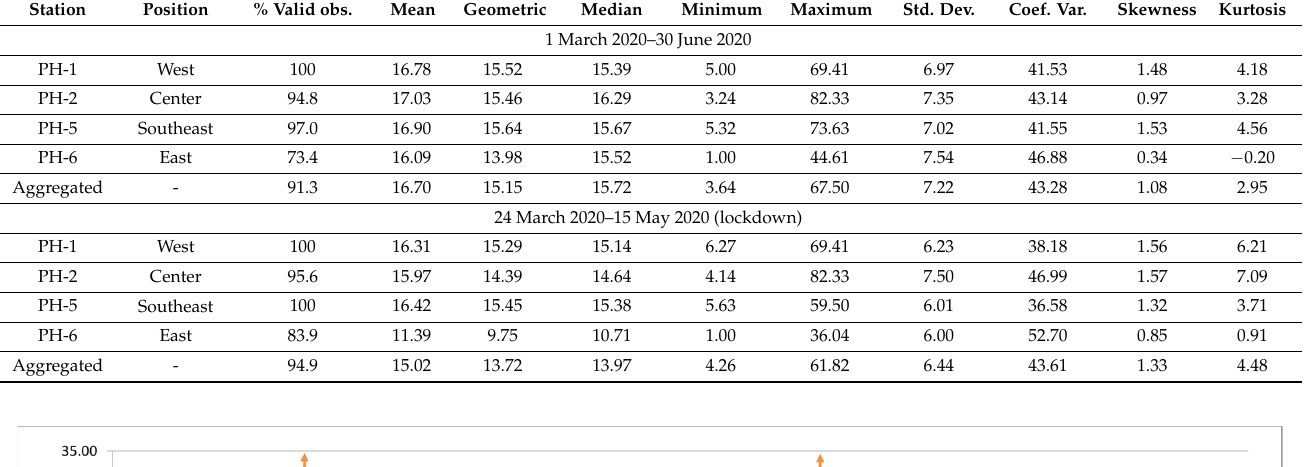
Table 2. Descriptive statistics of the PM10 concentrations ( µ g m − 3 ) recorded at the 4 automatic